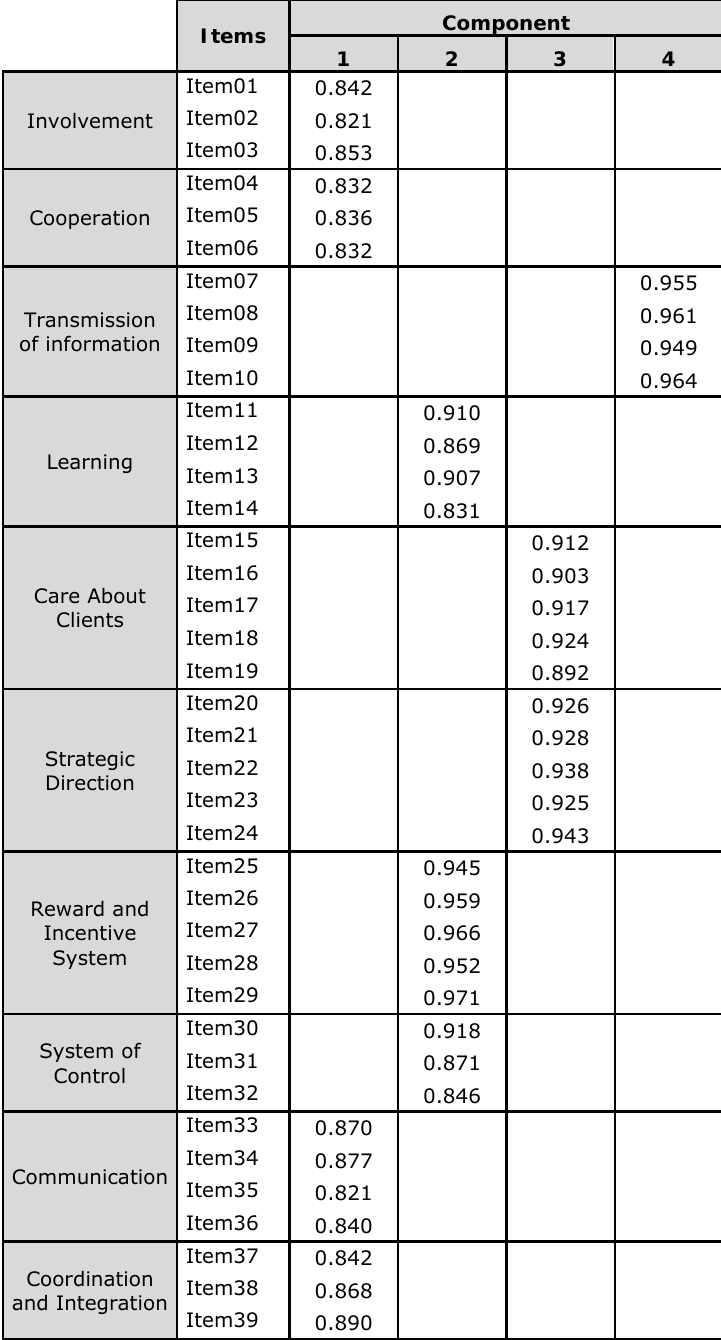
Table 1. “Factor Analysis (Rotated Component Matrix / Organizational Culture)”. (Extraction Method: Principal Component Analysis. Rotation Method: Varimax with Kaiser